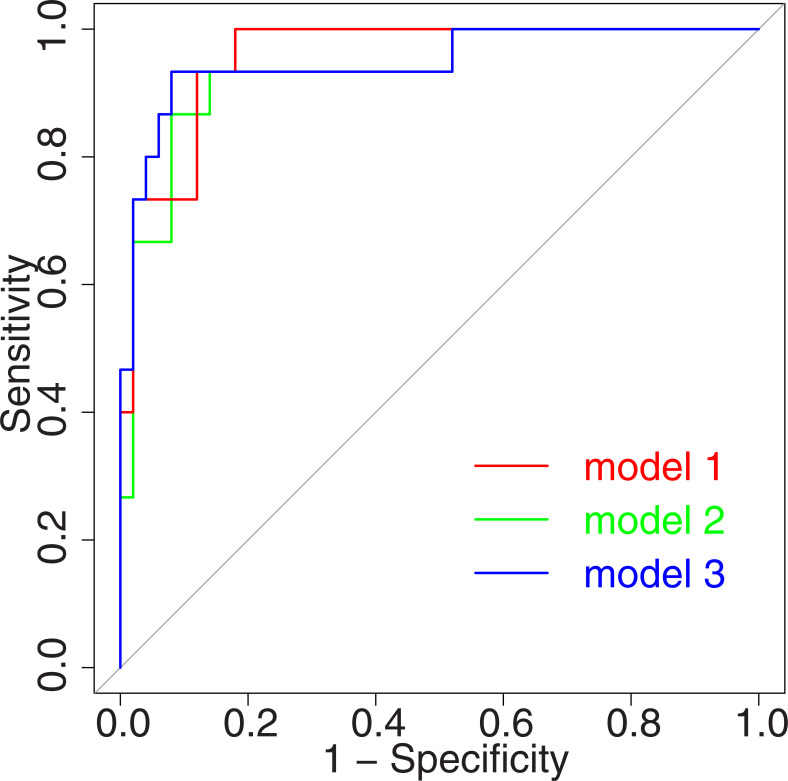
Receiver operating characteristic curves of three models for discriminating delayed neurological sequelae.